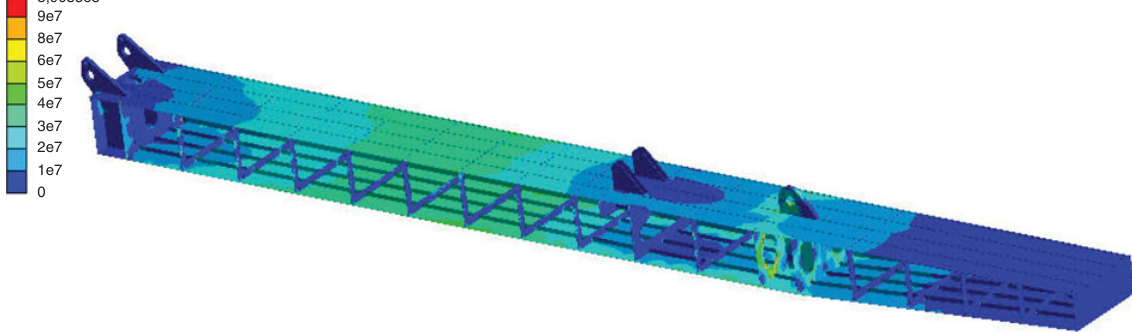
Fig. 4. Trolley with container is between root hinge of console and clamping hinge of console. Stress state of console (Von Misses, MPa)